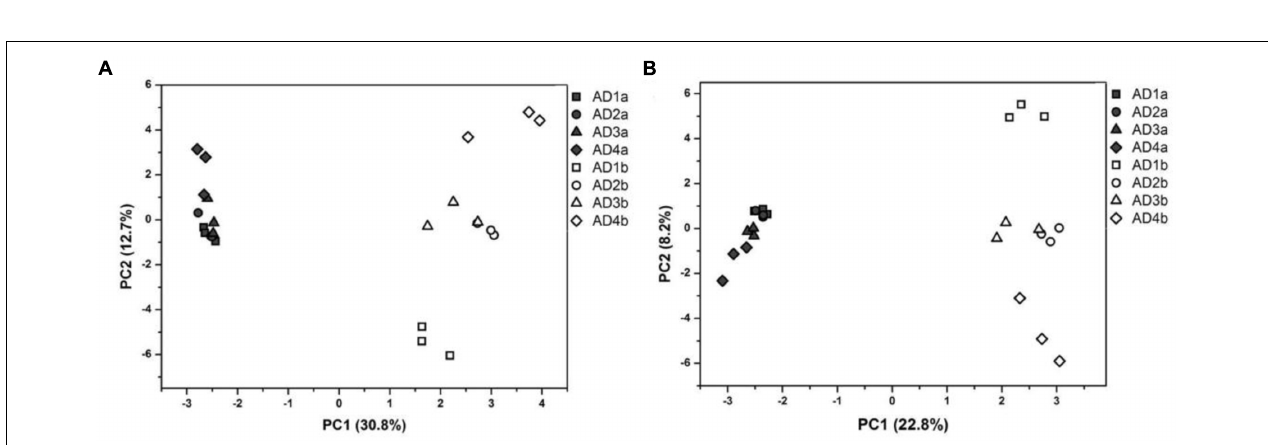
FIGURE 3 | Principal component analyses of total bacteria (A) and bacteria without cyanobacteria (B) . Filled symbols represent PAB, and hollow symbols represent FLB, respectively.